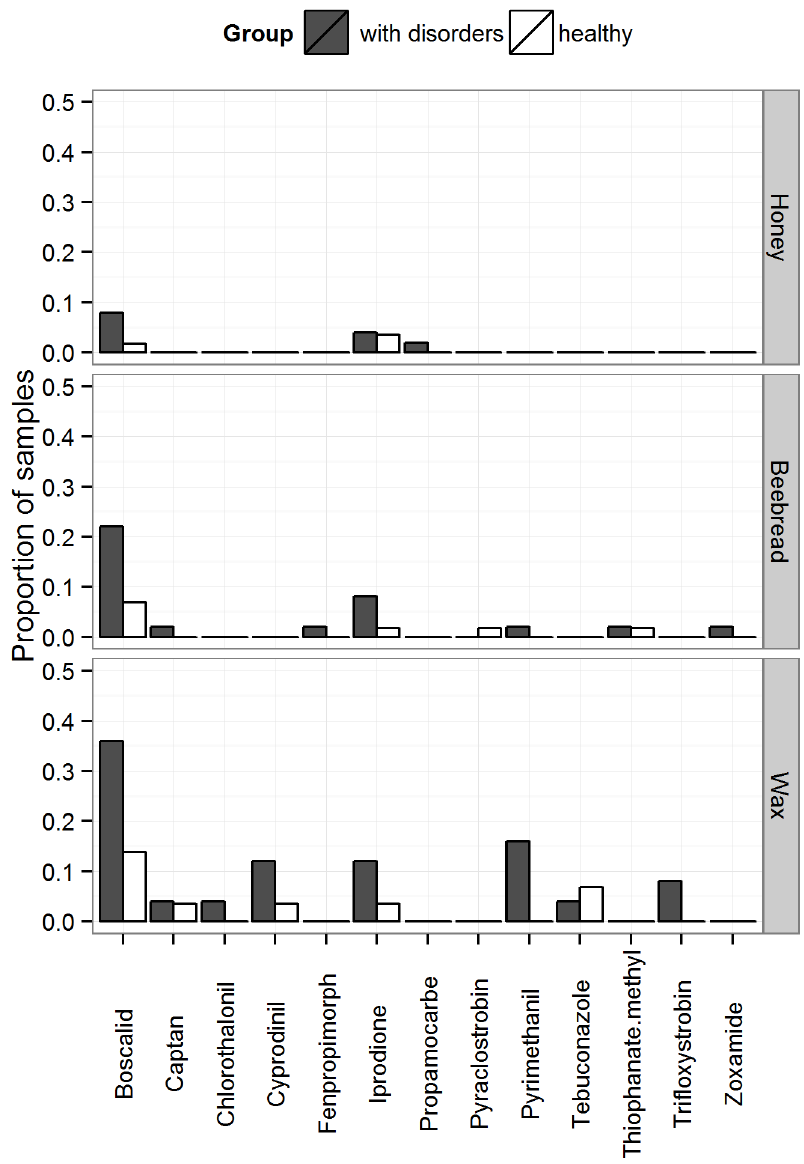
Figure 5. Proportion of samples containing residues of fungicides in the different beekeeping matrices (honey, beebread and wax). Data shown for the group with disorders (grey, n=25 colonies) and the healthy one (white, n=29 colonies).